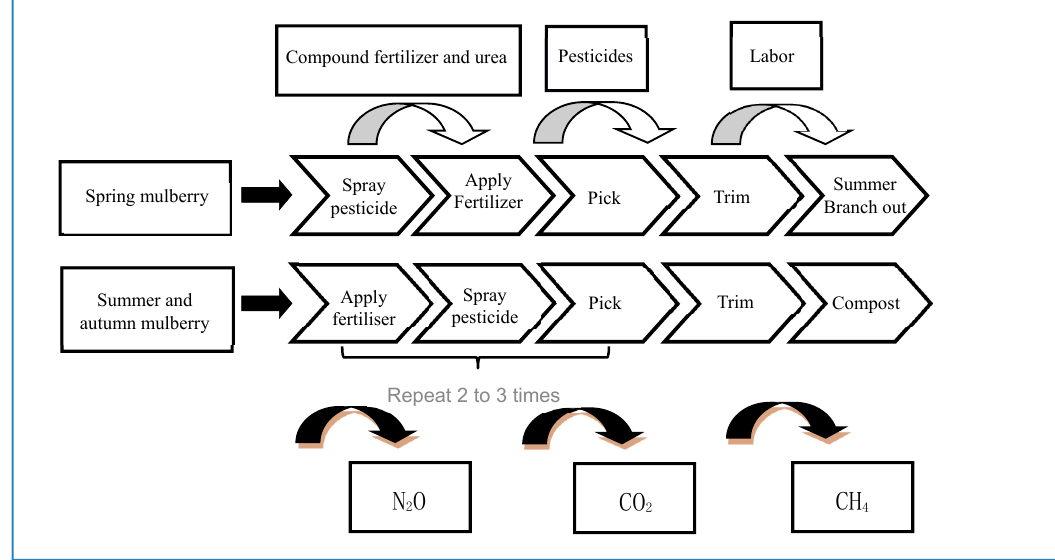
Figure 2. Boundary of carbon footprint accounting system in mulberry planting stage.